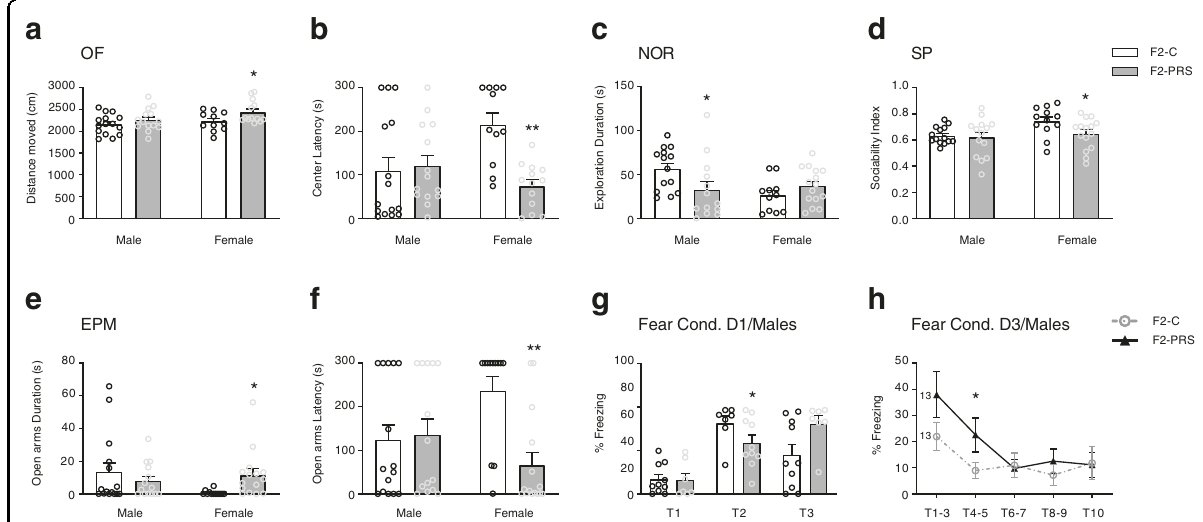
Fig. 5 PRS-induced behavioral changes in F2 male and female offspring. a F2-PRS females, but not males, exhibit higher locomotion during the fi rst 5 min of the OF test (one-way ANOVA, F = 4.7, p < 0.05). b Female, but not male, F2-PRS rats show decreased latency to enter the OF center 1,22 (one-way ANOVA, F 1,22 = 23.1, p < 0.0001). c Male, but not female, F2-PRS rats exhibit less exploration in the Test Phase of NOR compared with F2-C males (one-way ANOVA, F 1,25 = 4.3, p < 0.05). d Female, but not male, F2-PRS rats demonstrate a lower sociability index (one-way ANOVA, F 1,25 = 4.5, p < 0.05). In EPM ( e, f ), Female F2-PRS rats spend more time in the open arms ( e ; one-way ANOVA, F 1,25 = 6.9, p < 0.05) and enter the open arms sooner ( f ; one-way ANOVA, F 1,25 = 14.8, p < 0.001) than their F2-C controls. No PRS effects are found in male F2 offspring. g Fear conditioning, Day 1: PRS induces lower freezing levels in male F2 offspring, particularly during the second tone presentation ( g ; repeated-measures ANOVA, tone × group F 2,30 = 3.4, p < 0.05). h PRS has no effect on freezing during the fi rst 3 tones in male F2 offspring. During the 7 subsequent tones, F2-PRS rats extinguish the fear response slower than their F2-C counterparts. In particular, freezing in male F2-PRS offspring tends to be higher during the fi rst extinction tones (tone, F 2.84,68.2 = 3.2, p < 0.05, group F 1,24 = 3.5, p = 0.073). Data presented as individual values, with bars and whiskers representing means and standard errors, respectively ( a – g ) or as means and standard errors ( h ). Post-hoc * p < 0.05, ** p < 0.001, relative to